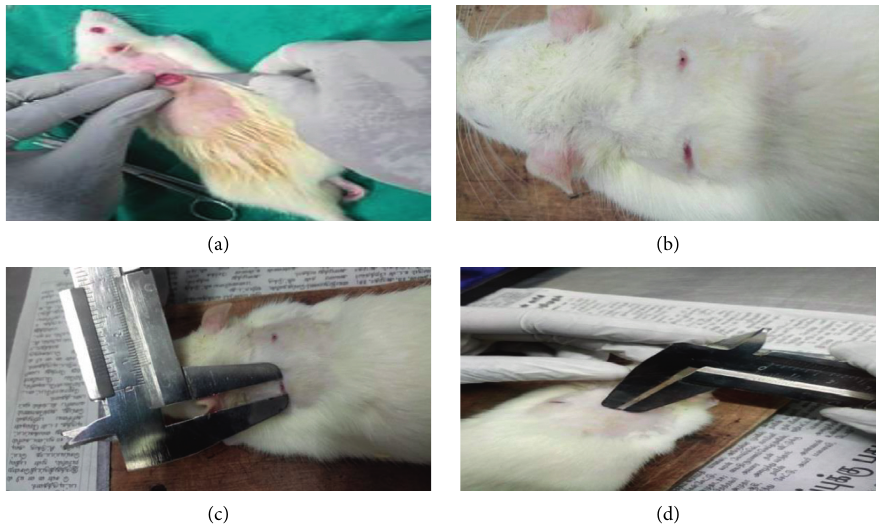
Figure 9: Group I animals tested with a combination of dHAM, TSP gel, and immature coconut fiber compared with untreated (control). (a) dHAM surgery on the right side with TSP gel and coconut fiber suture for 10mm biopsy punch diameter wound. (b) After 11 days, wound reduction site on the right side is better than the nontreated control. (c) Wound site measurement (6mm) at the nontreated control site after 11 days. (d) Wound site measurement (2mm) at the test site (dHAM+TSP gel+ coconut Fiber) after 11 days. Values are expressed as mean ± SE ( n � 3), where p ≤ 0 .